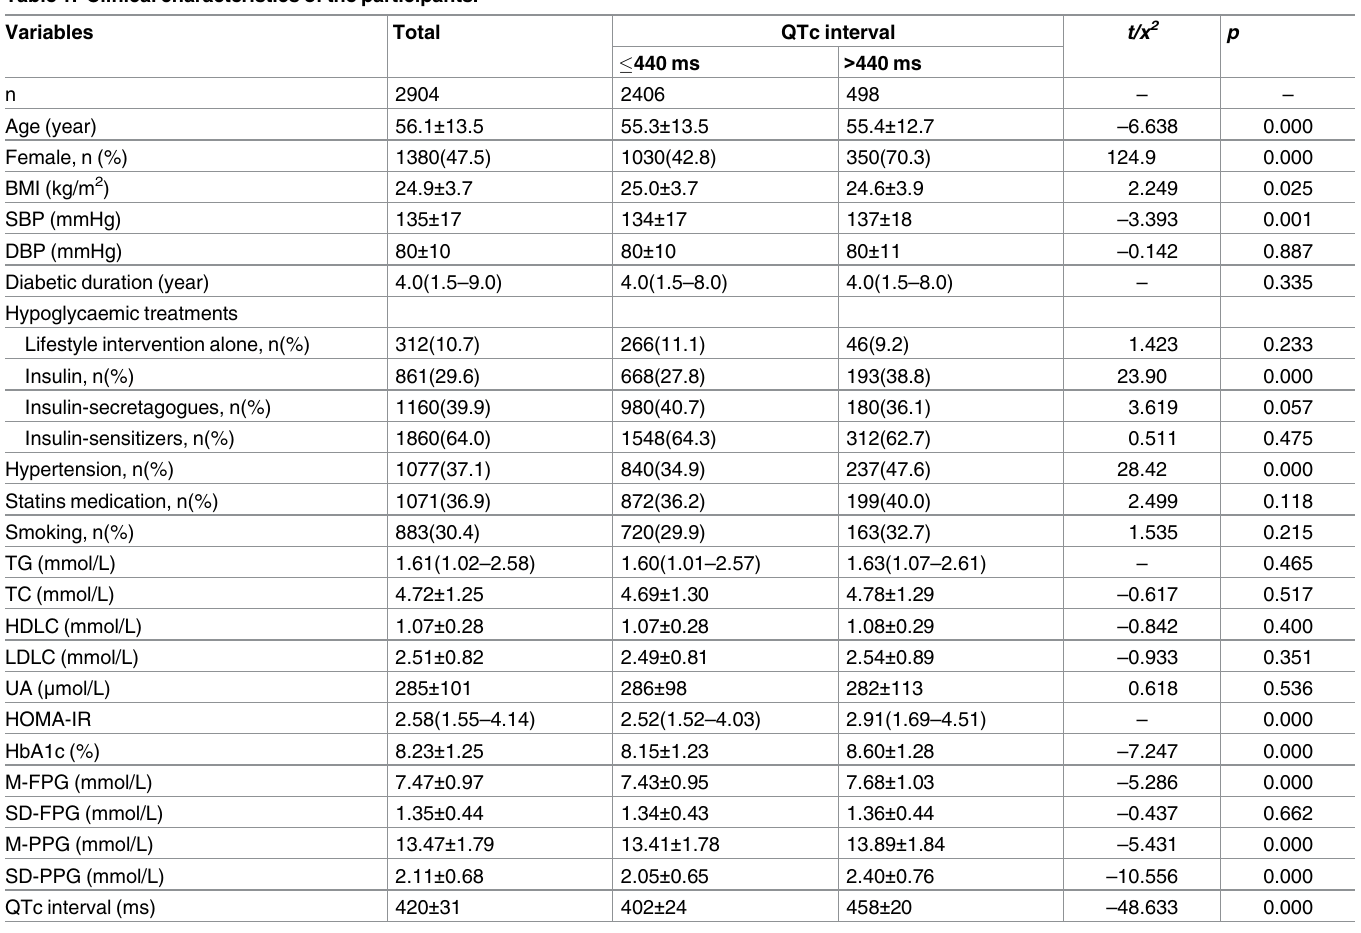
Table 1. Clinical characteristics of the